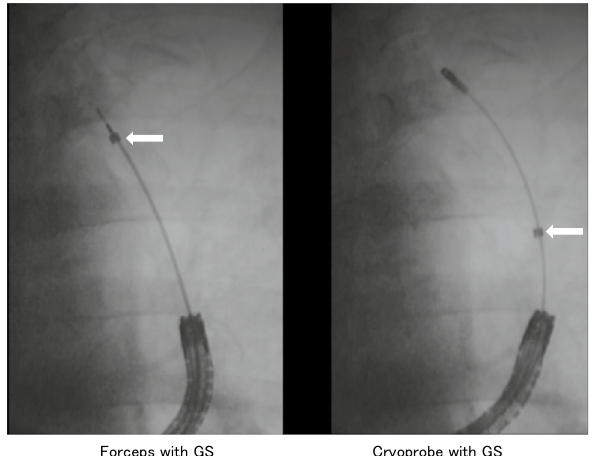
Figure 2. Guide sheath displaced due to cryoprobe insertion. Figure 1 shows one case of GS displacement by the TBLC probe insertion for a lesion at the lung apex. White arrows indicate GS tips. The tip of the GS is displaced by the insertion of the cryoprobe and is significantly different from the site where the forceps biopsy was performed. GS guide